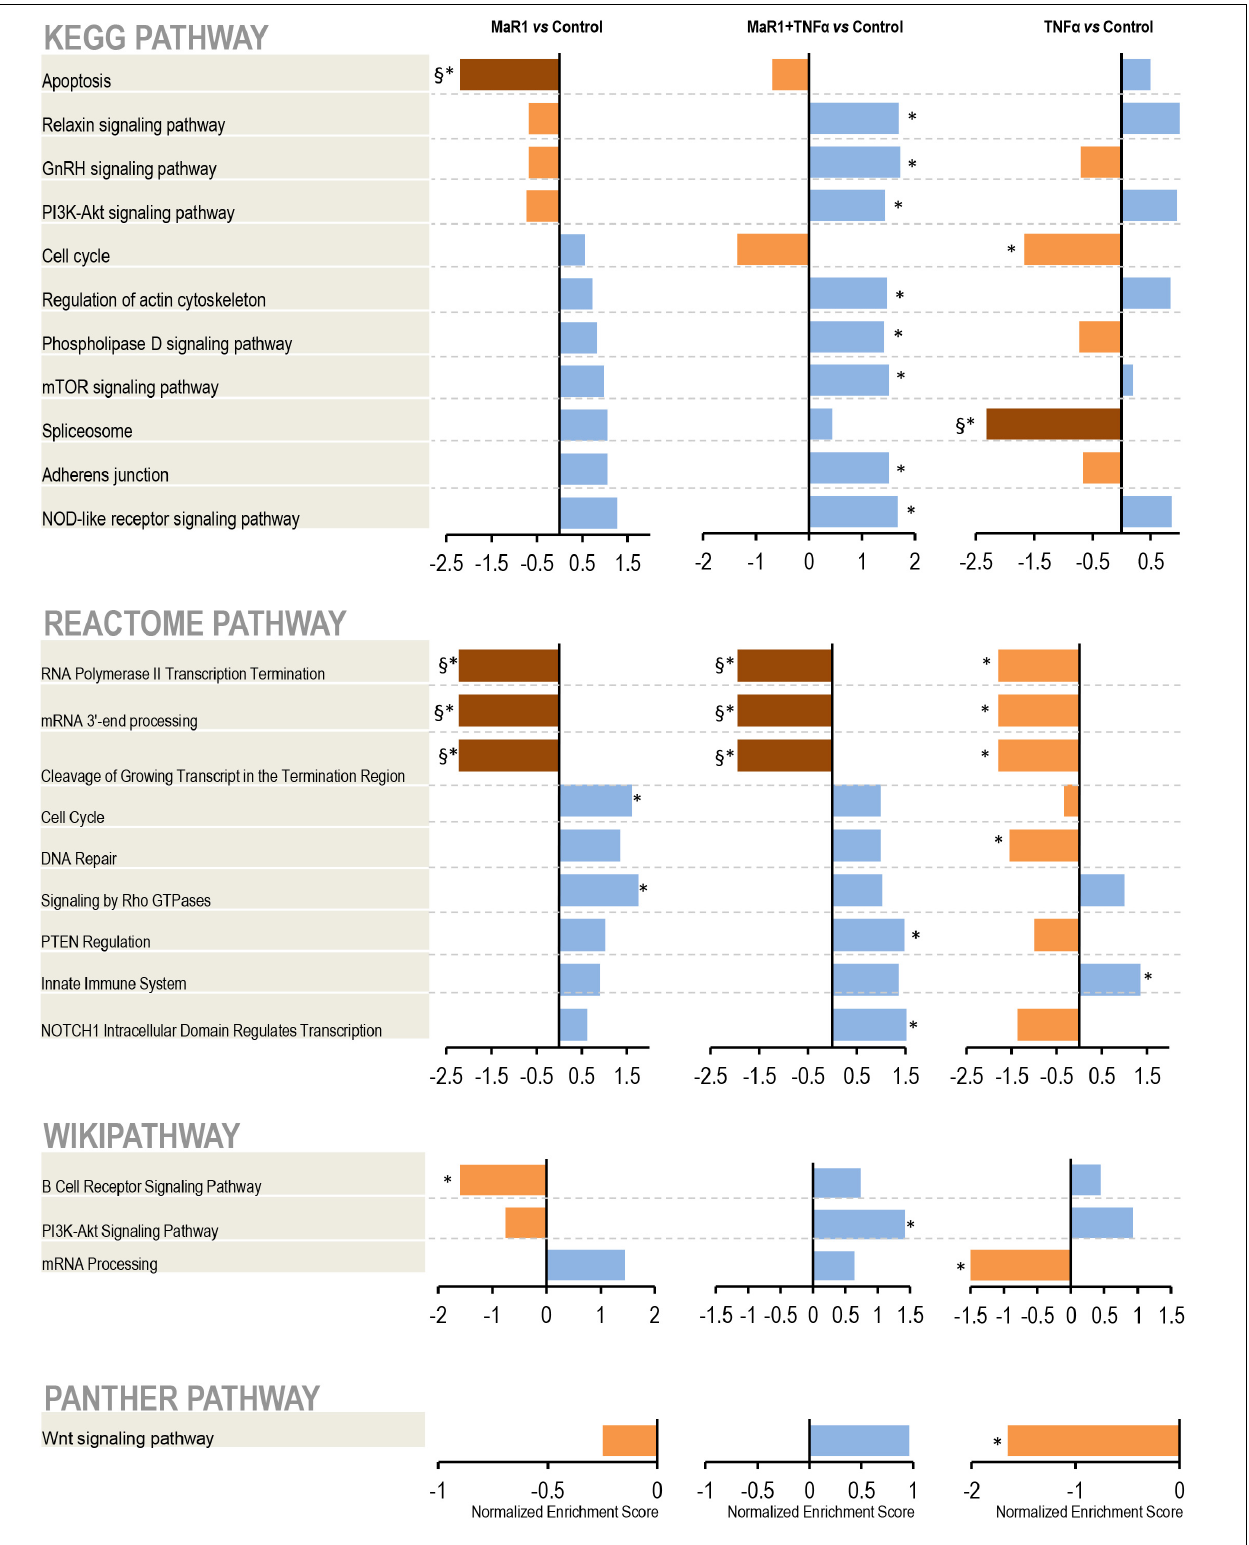
Frontiers in Immunology |